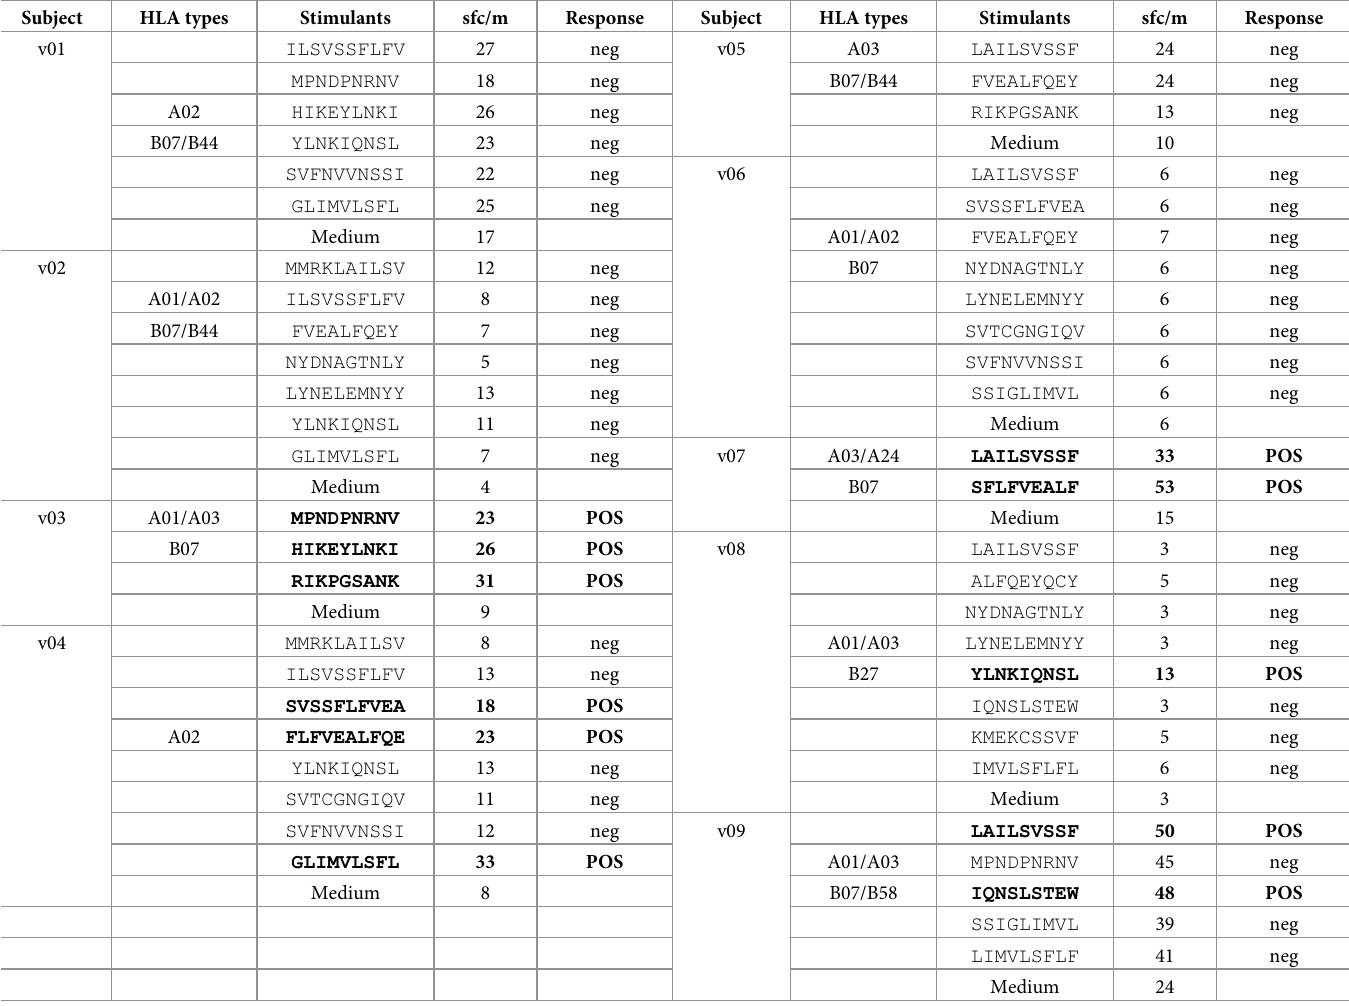
Table 2. Interferon gamma responses by unfractionated PBMCs to the 8-10mer CSP peptide